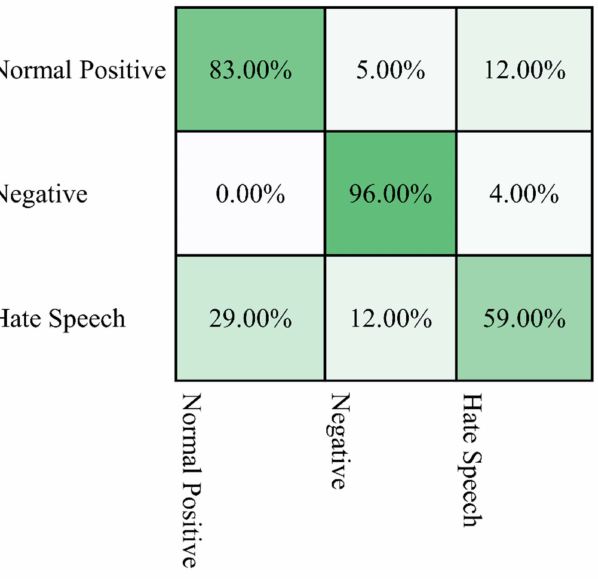
Figure 5. Confusion matrix of the experimental results using the proposed deep recurrent neural network model-based classification method for three classes of Arabic